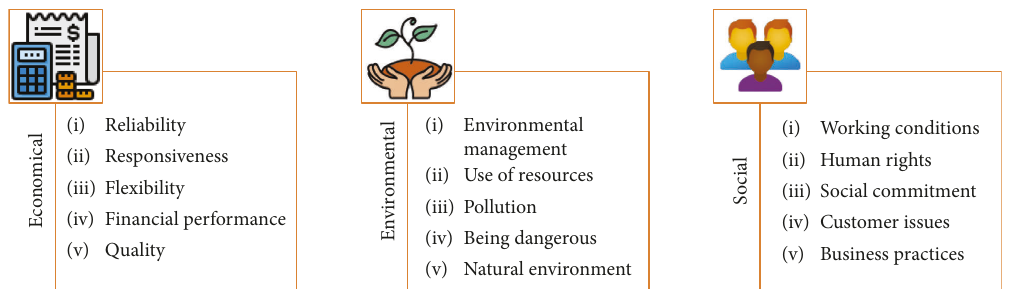
Figure 3: Classification of sustainability indicators